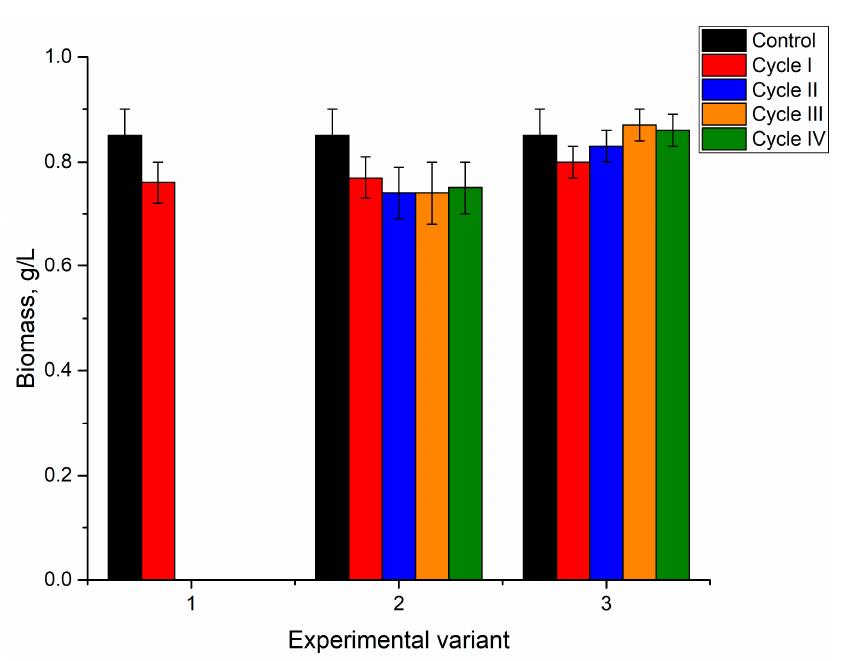
Figure 11. The amount of biomass in spirulina during repeated cultivation in the medium contain- ing metal ions at concentrations: nickel 2.5–10 mg/L, copper 1–5 mg/L, zinc 0.5–2 mg/L, and molyb- denum 0.5 mg/L.